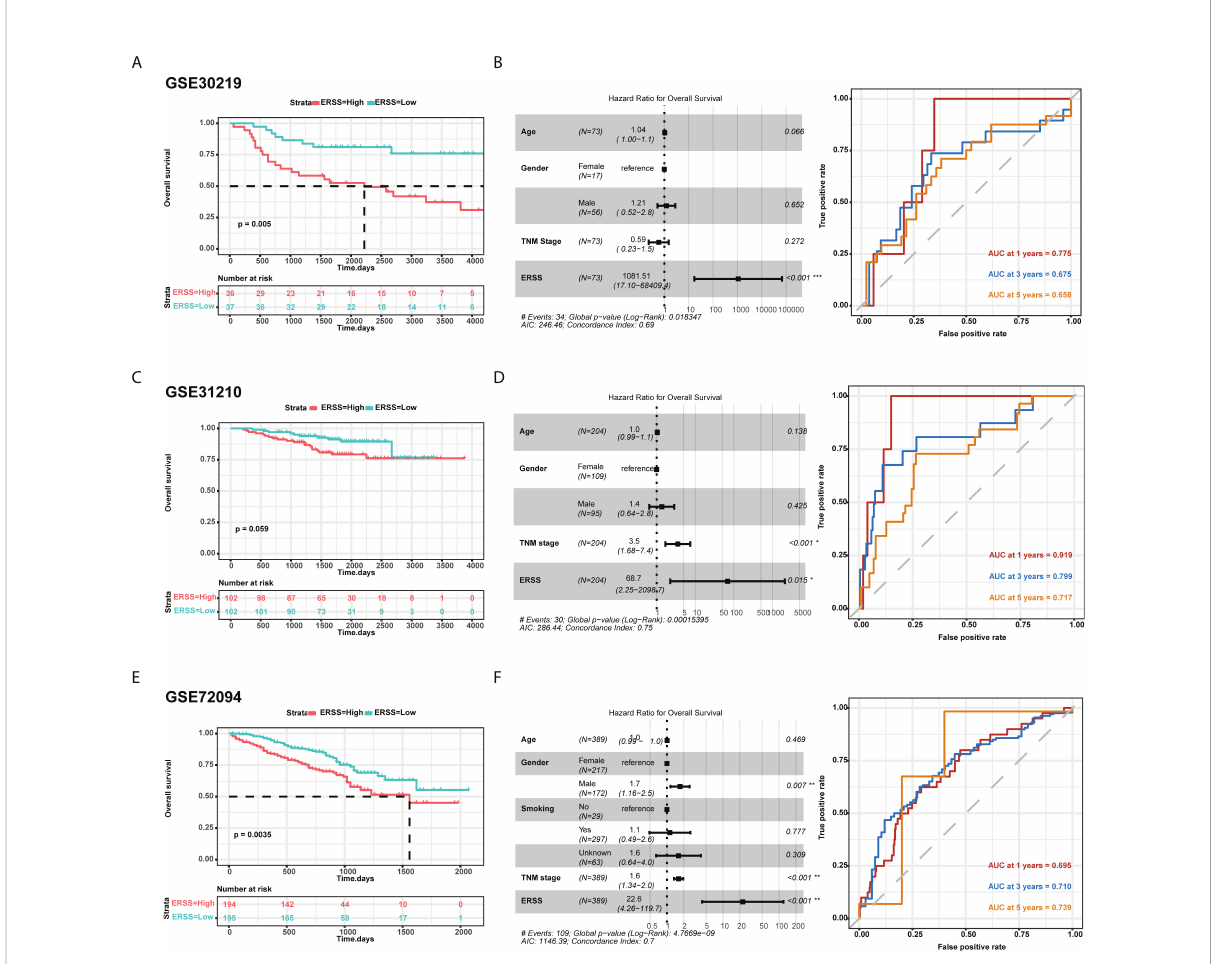
FIGURE 3 External validation of ERSS in GEO cohorts. (A, B) Validation in GSE30219 cohort showed that high ERSS signi fi cantly correlated with shorter OS ( p = 0.005) and independently predicted shorter OS ( p < 0.001). (C) The AUC values of ERSS for 1-, 3-, and 5-year OS were 0.775, 0.675, and 0.658, respectively. (D) In the GSE31210 cohort, patients with high ERSS showed shorter OS ( p = 0.059). (E) Higher ERSS was an independent predictor for worse OS ( p = 0.015). (F) The AUC values of ERSS for 1, 3, and 5 years OS were 0.919, 0.799, and 0.717, respectively. (G, H) Similarly, univariate and multivariate analyses showed that high ERSS predicts worse OS in the GSE72094 cohort. (F) The AUC values of ERSS for 1, 3, and 5 years OS were 0.695, 0.710, and 0.739, respectively. ERSS, endoplasmic reticulum stress score; OS, overall survival; AUC, the area under curve. * p <0.05, ** p <0.01, *** p